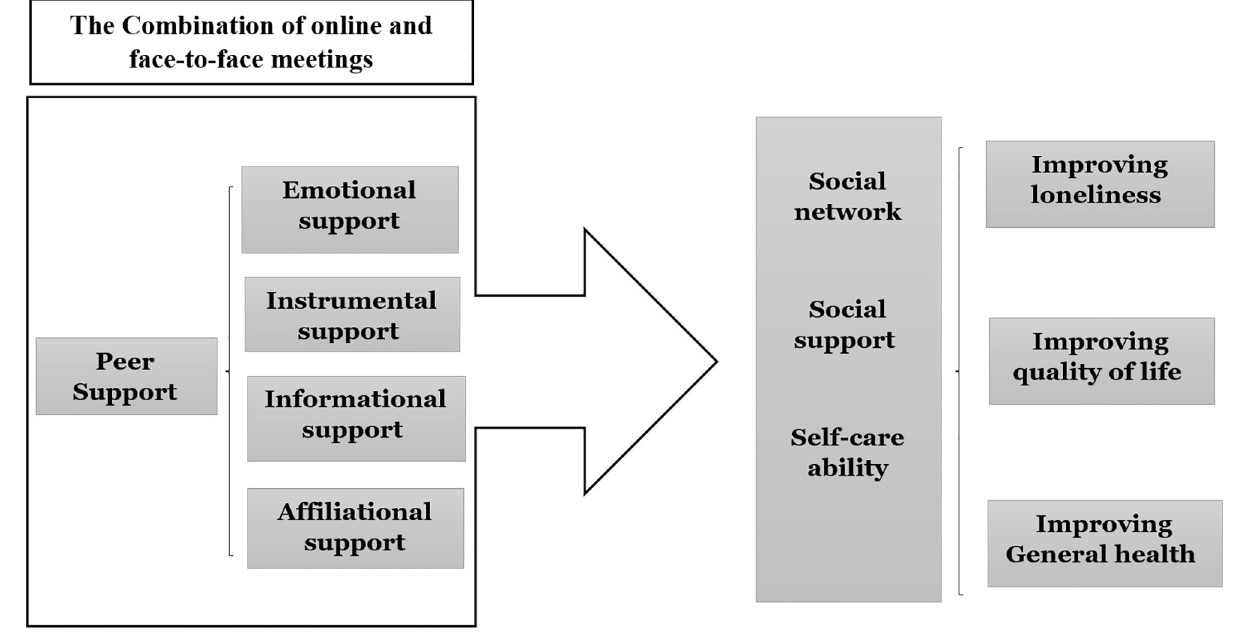
Fig 1. The conceptual framework designed based on social support